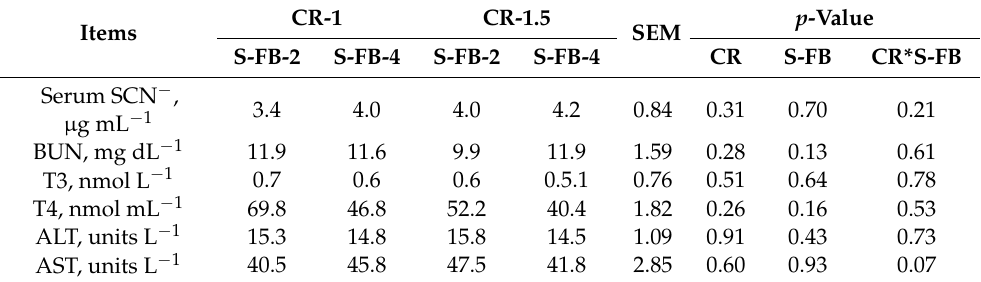
Table 5. Effect of fresh cassava root (CR) and solid feed-block containing high sulfur (S-FB)